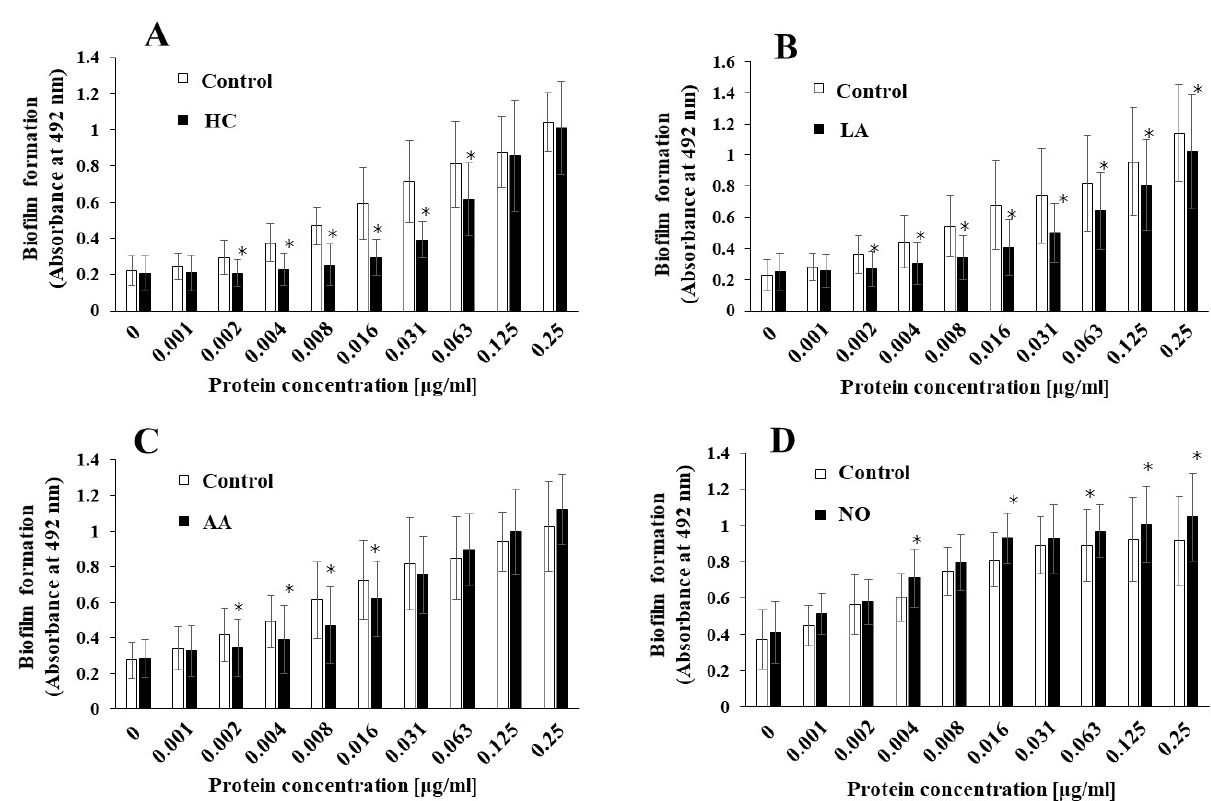
Figure 2. Effects of initial pH condition on the MVs-dependent biofilm formation. Biofilm formation of S. mutans UA159 gtfBC - was quantitatively assessed in TSB with 0.25% sucrose with various concentration of MVs from S. mutans UA159 in initial pH6.0 condition prepared with HC ( A ), LA ( B ) and AA ( C ), and initial pH 8.0 condition prepared with NO ( D ), and compared with control (no preparation). The data indicate the mean ± standard deviation (SD) of three independent experiments. The asterisks indicate a significant difference between the groups (*: p < 0.05, MVs in control condition vs. MVs in initial pH6.0 or 8.0 conditions).